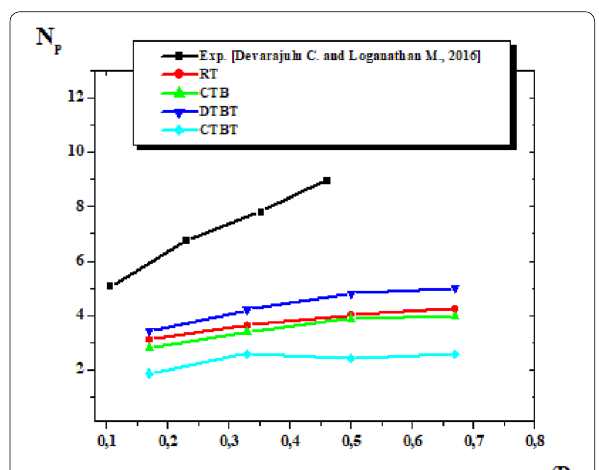
Figure 26 Power number according the impeller clearance ratio for different agitator’s types, Re